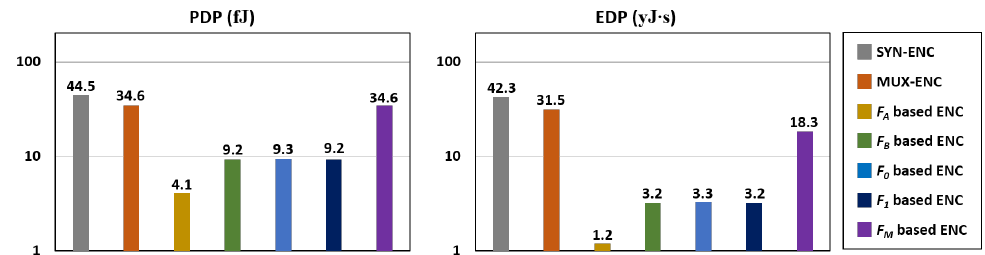
Figure 10. PDP and EDP comparisons. Y axes are in log